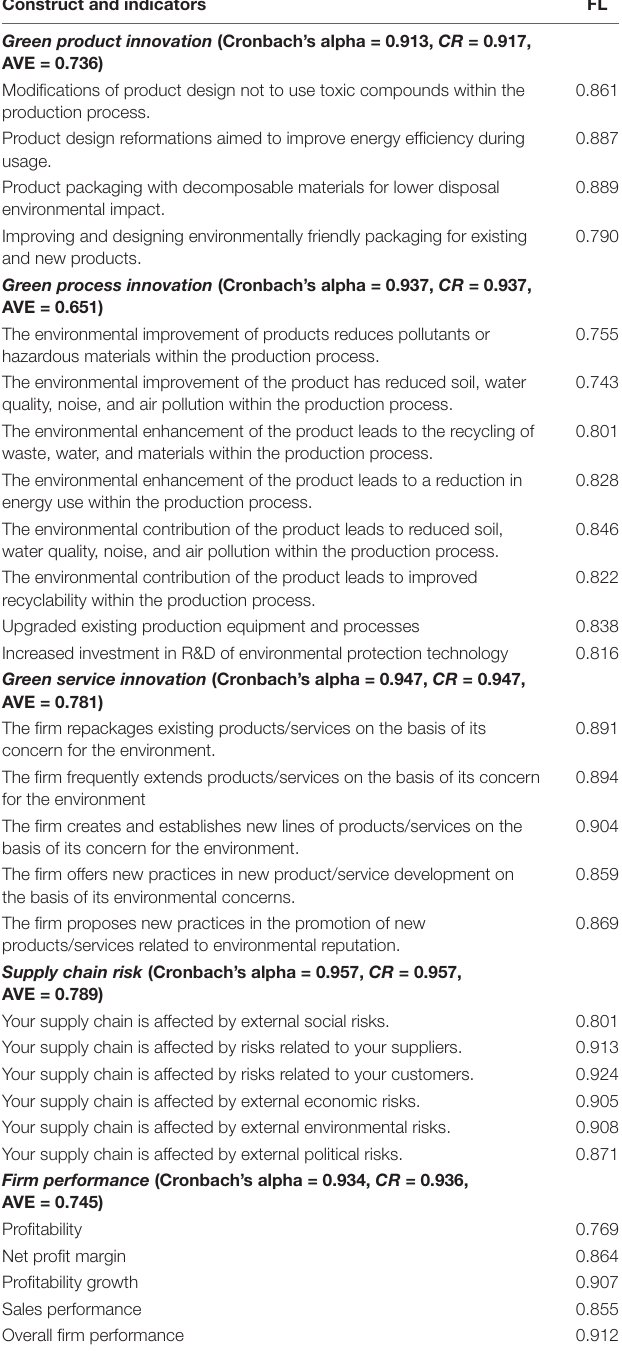
TABLE 1 | Results of reliability and validity assessments of the constructs. Construct and